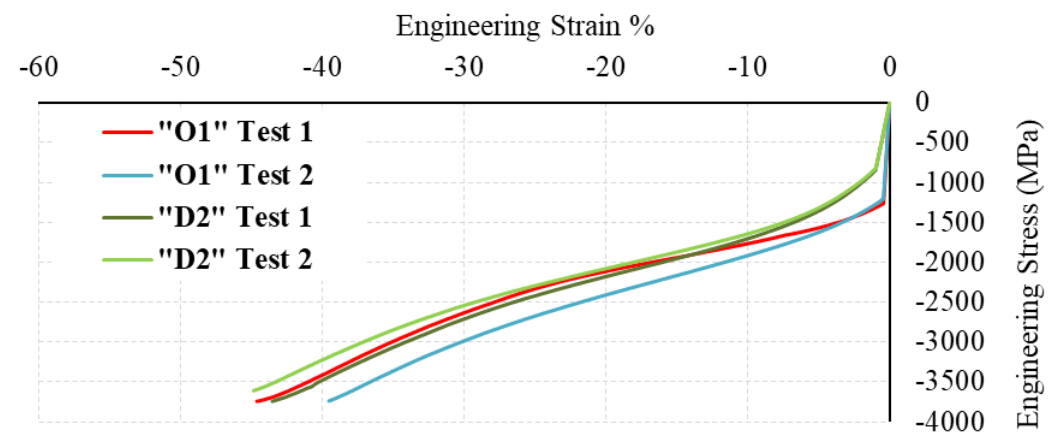
Figure 4. Compression engineering stress–strain curves for “D2” and “O1” tool steels.